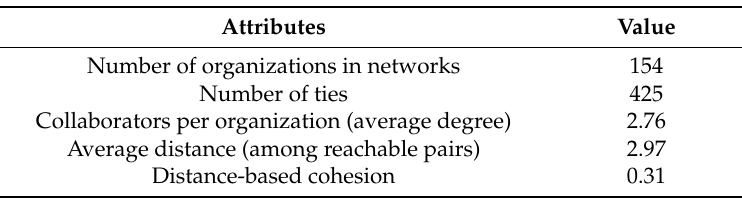
Table 3. Summary of network